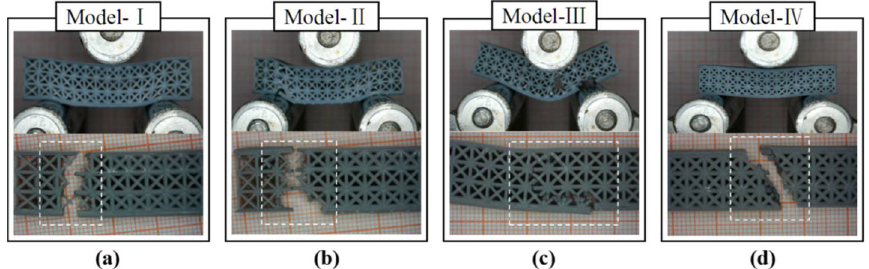
Figure 11. The failure modes of the proposed lattice structures: ( a ) Heterogeneous lattice No. 1, ( b ) Heterogeneous lattice No. 2, ( c ) Uniform model with FCC strut diameter of 0.8 mm, ( d ) Uniform model with FCC strut diameter of 1 mm.